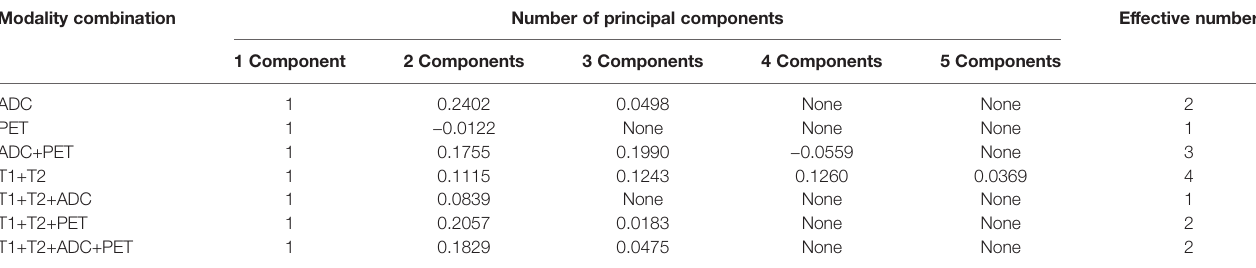
TABLE 2 | Score of crossvalidity analysis ( Qh 2